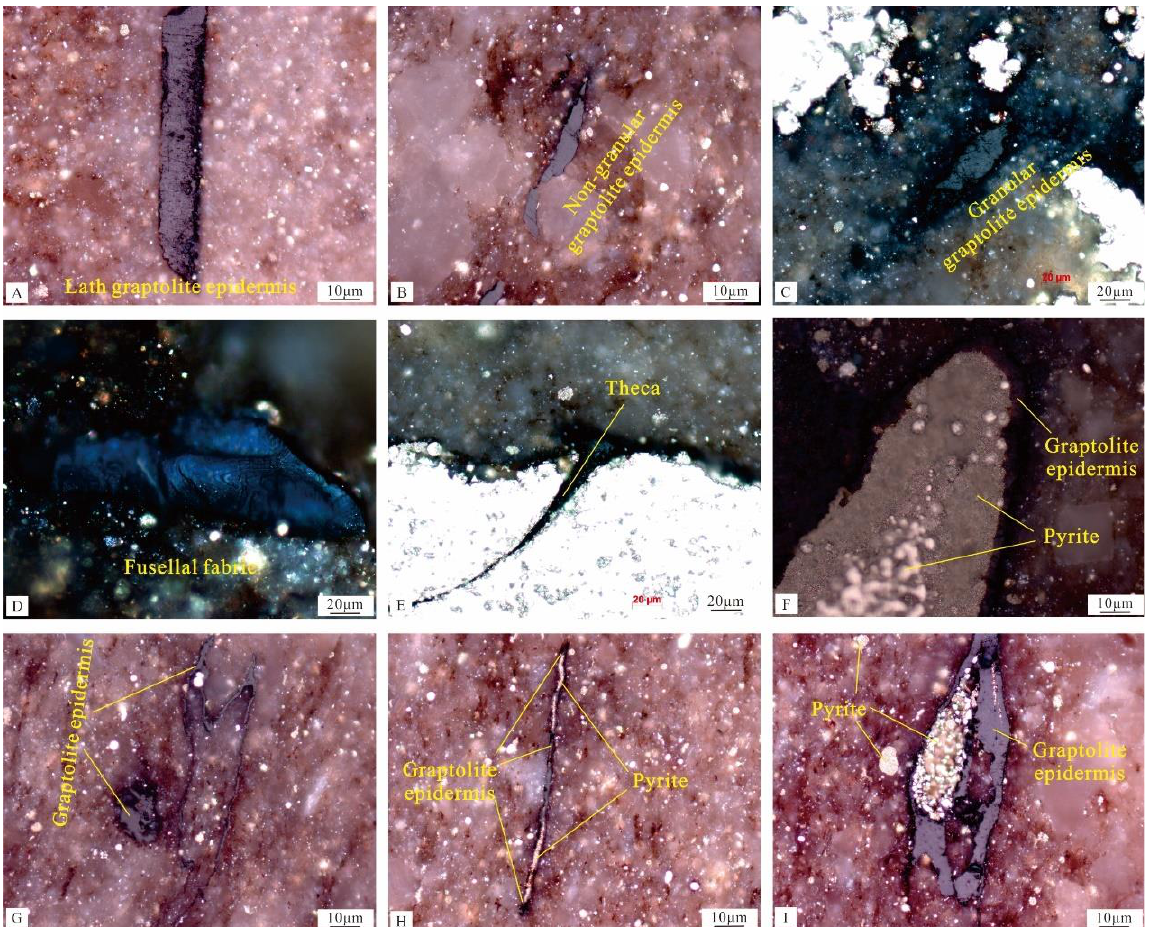
Figure 3. Characteristics of graptolite under the electron microscope. ( A ) lath graptolite epidermis, //, 3865.19 m; ( B ) nongranular graptolite epidermis, ⊥ , 3865.19 m; ( C ) granular graptolite epidermis, //, 3871.2 m; ( D ) fusellal fabric, //, 3868.93 m; ( E ) graptolite filled with pyrite retains the theca, //, 3871.2 m. ( F ) The graptolite cavity is filled with pyrite of different crystal forms. //, 3865.19 m; ( G ) graptolite epidermis on the vertical plane, ⊥ , 3865.19 m; ( H ) graptolite filled with pyrite, ⊥ , 3865.19 m; ( I ) graptolite partially filled with pyrite, ⊥ , 3865.19 m.